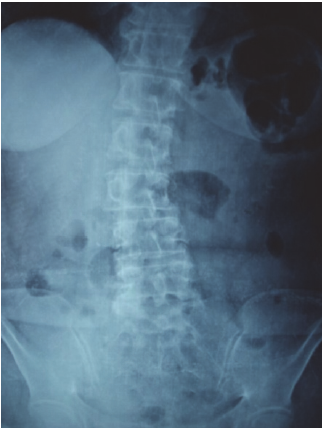
Figure 1: Abdominal X-ray on admission. Normal findings.